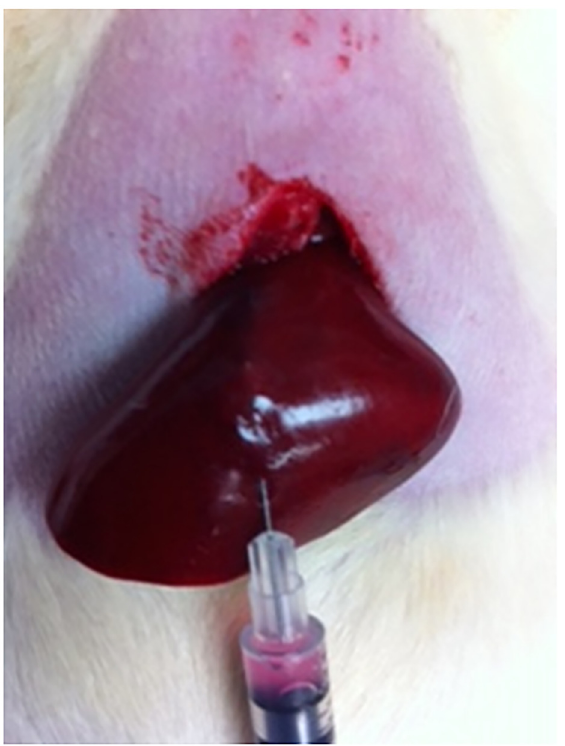
Fig 1. Tumor inoculation. Using a 29 G needle, 5 * 106 CC-531 cells in a cellular suspension were injected into the anterior subcapsular left hepatic lobe.